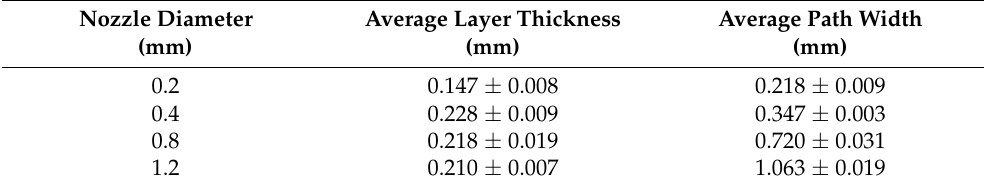
Table 4. Optically measured geometrical features of manufactured samples in the function of noz- zle’s